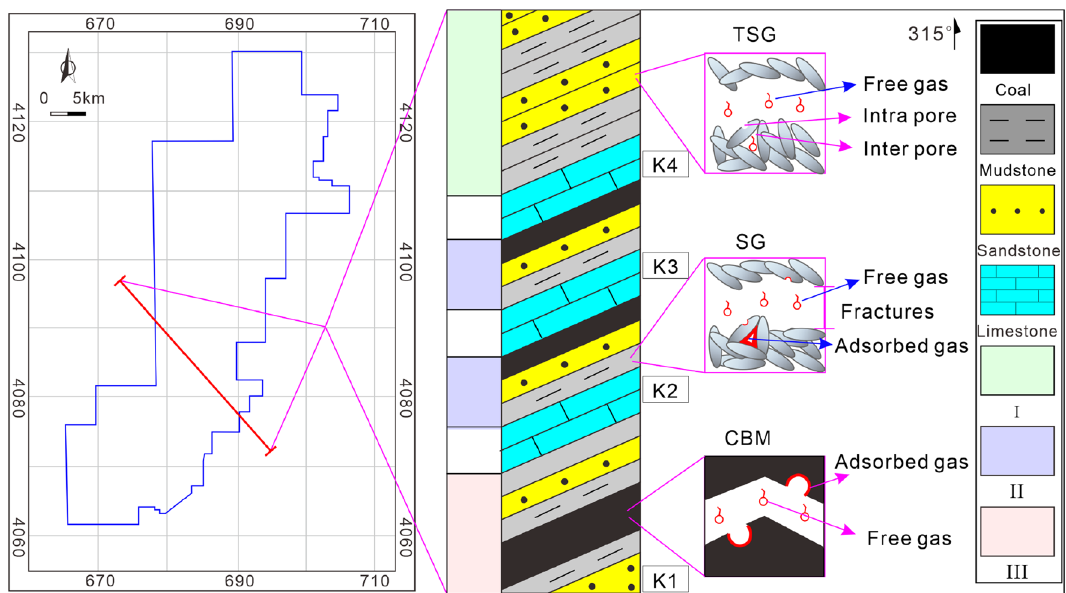
Figure 9. Coal-measure gas superimposed accumulation model, mechanism, and combination of the Taiyuan Formation. TSG is tight sandstone gas (mainly free gas), SG is shale gas (including free gas and adsorbed gas), CBM is coalbed methane (mainly adsorbed gas), Intra pore is the intragranular pore, and inter pore is the intergranular pore, I–III represents combinations I–III. The gas occurrence states and pore types are drawn referring to ref 43–47